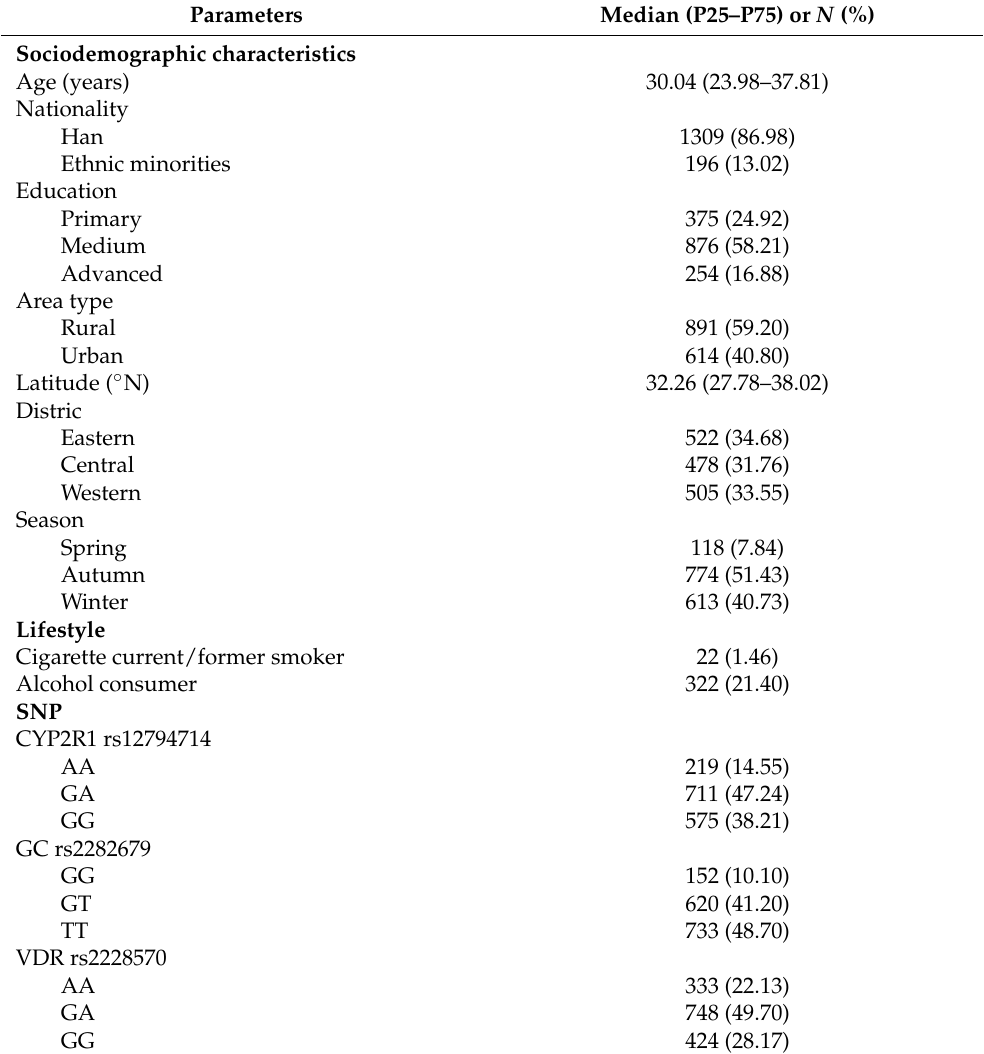
Table 1. Characteristics of the studied population (medians and interquartile ranges